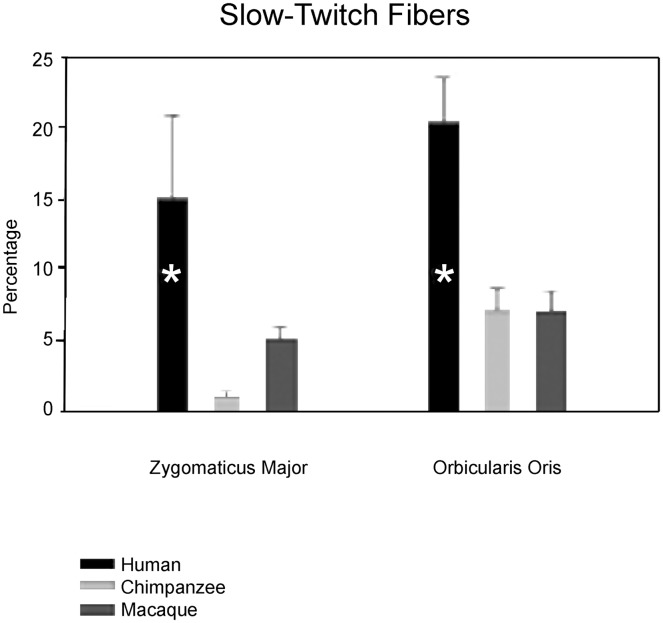
Percentages of slow-twitch myosin fibers in facial muscles.Results of one-way ANOVA and post-hoc Least Squares Difference testing in the orbicularis oris muscle indicate that humans have the highest percentage of slow-twitch myosin fibers (human > chimpanzee = macaque) at the p<0.05 level of statistical significance. For the ZM, Least Squares Difference testing was unable to separate chimpanzees from humans at the p<0.05 level of statistical significance. The presence of a “*” indicates that the group mean percentage was significantly different from the other groups. Means with SEM are shown.